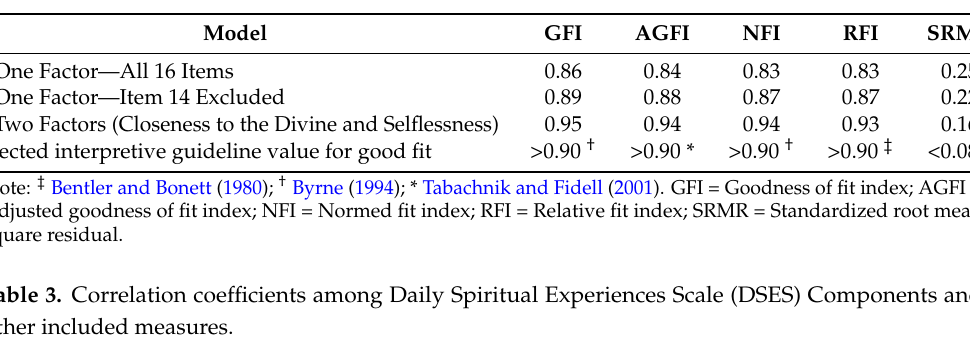
Table 2. Results from CFAs.